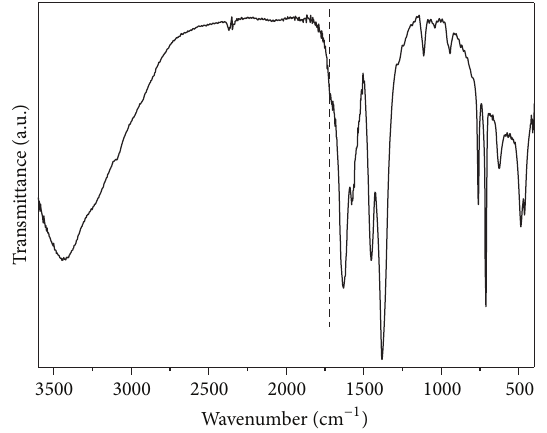
Figure 4: FT-IR spectrum of the synthesized